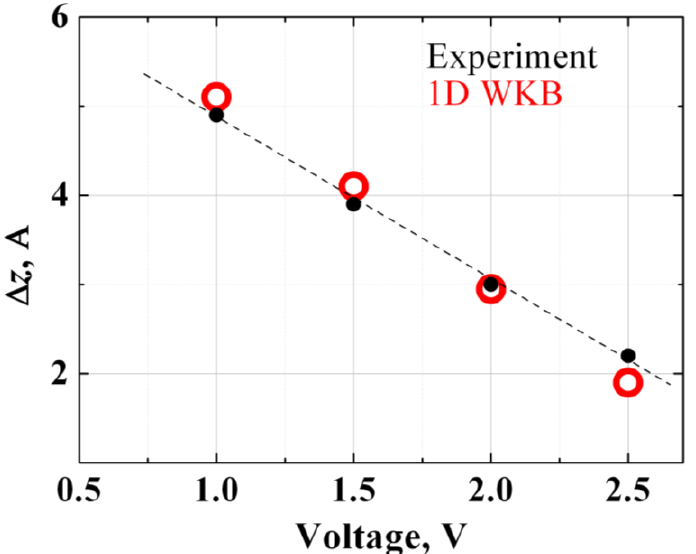
Figure 10. Comparison of the vertical probe offset to compensate for the expected tunnel current variation as a function of bias with the contrast behavior (presented in angstroms; see Figure 5e) for the scanning areas near the boundary between the (7 × 7) N and (8 × 8) structures. The black solid dots and the dotted line show the experimental contrast versus voltage (see Figure 5e), and the red blank dots present the estimation of the necessary probe offset Δ z to compensate for the expected change in the current. It can be seen that as the voltage across the tunnel gap decreases, the required vertical probe offset increas- es, which corresponds qualitatively and quantitatively to the empirical behavior of the contrast versus voltage. Thus, it is proposed to use the procedure for correcting the STS spectra of differen- tial conductivity to match the behavior of the STM image contrast, as a function of bias, which helps to solve the problem of quantitative determination of DOS by the STM/STS technique. In this work, the (7 × 7) N structure state spectrum was assumed to be known, and the correction of the (8 × 8) structure spectrum, according to the contrast behavior